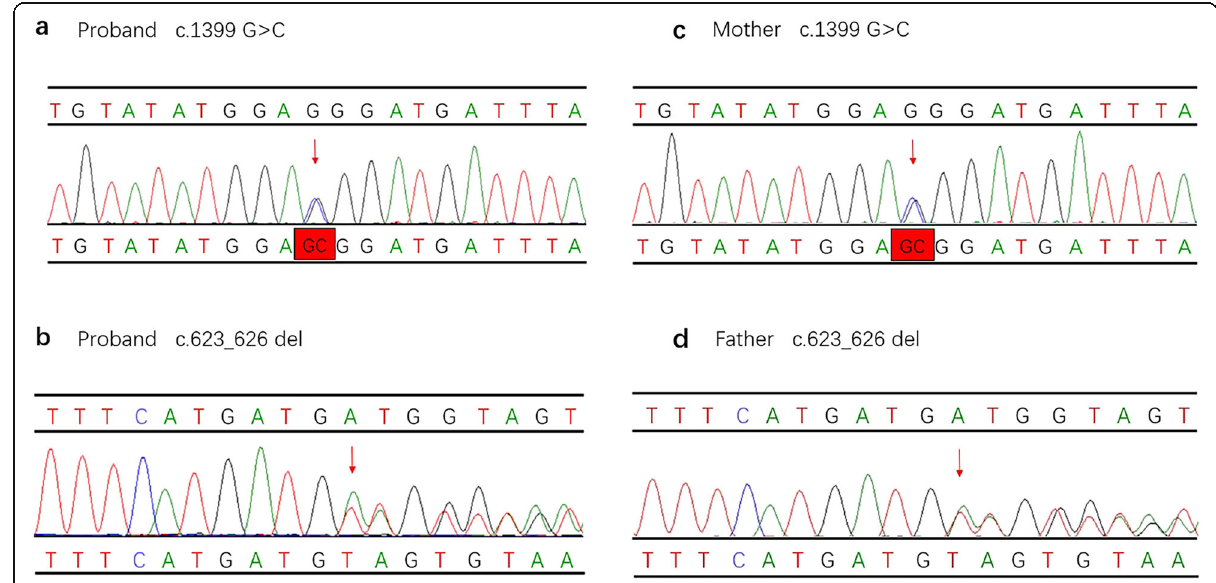
Fig. 2 Sequence analysis of ETFDH gene mutation in proband and her parents. The heterozygous variant c.1399G > C in exon 11 was identified in proband ( a ) and her mother ( c ); the variant c.623_626 del in exon 6 was identified in proband ( b ) and her father ( d